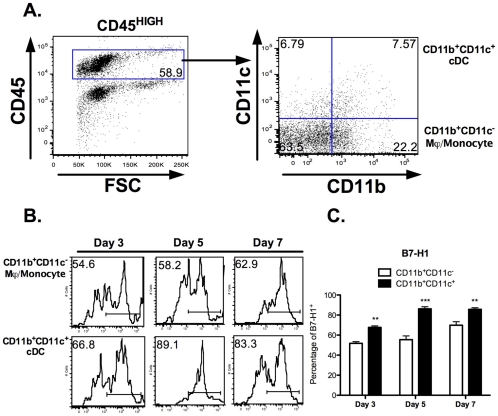
Expression of B7-H1 by CNS-Infiltrating APCs following TMEV infection in vivo.CNS-infiltrating APCs from TMEV-infected mice at days 3, 5 and 7 post-infection were analyzed for B7-H1 expression. A. Gating strategy identifying CD11b+CD11c− monocytes/macrophages and CD11b+CD11c+ dendritic cells based on CD45HIGH expression to exclude microglia. Numbers reflect total percentages of each cell population. B. Histograms of B7-H1 expression on monocyte/macrophage and dendritic cell populations following infection. C. Quantification of percent positive for B7-H1 are reflected based of negative staining from isotype controls and sham-infected cell populations. Black bars represent CD11b+CD11c− monocytes/macrophages, while white bars reflect CD11b+CD11c+ dendritic cells. The data is representative of three independent experiments with n = 4–5 mice/group expressed as the average ± SEM. **p<0.01, ***p<0.001 compared to CD11b+CD11c− infiltrating populations.